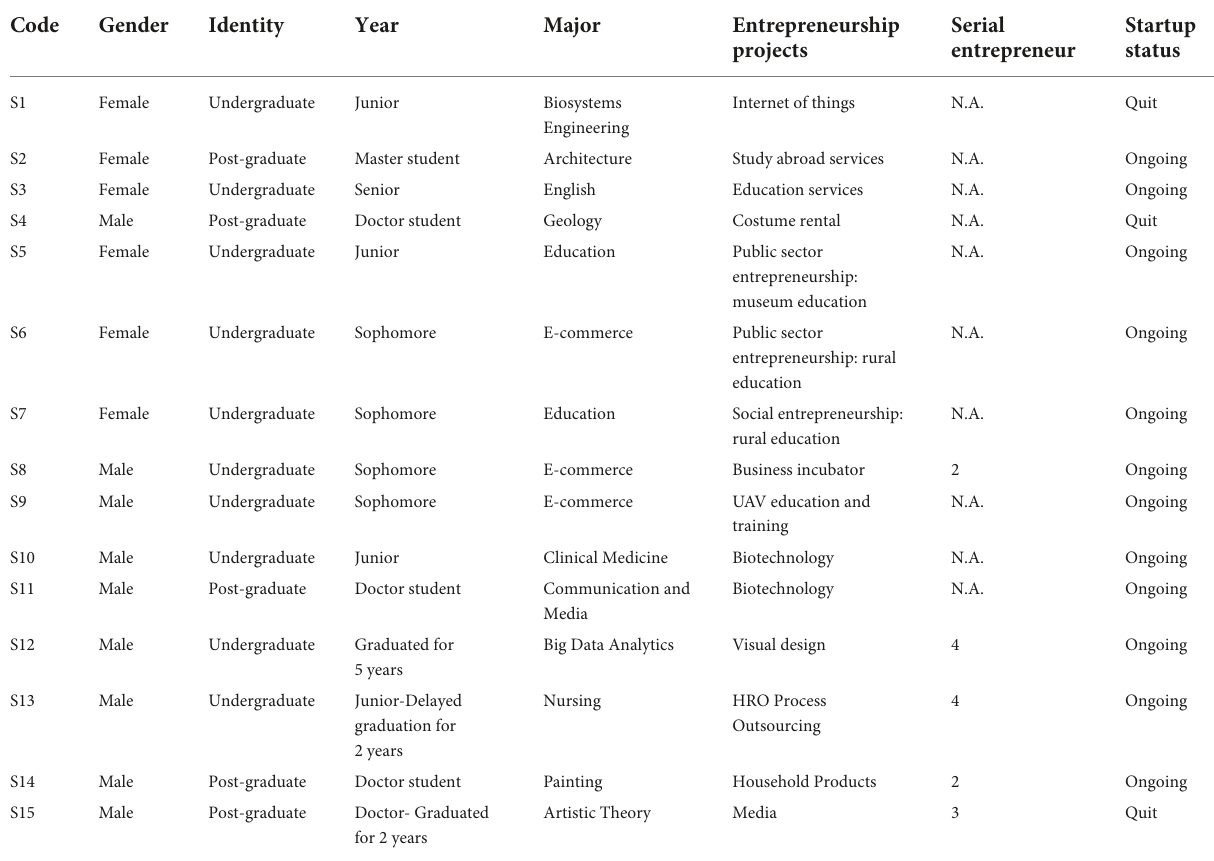
TABLE 3 Code list of